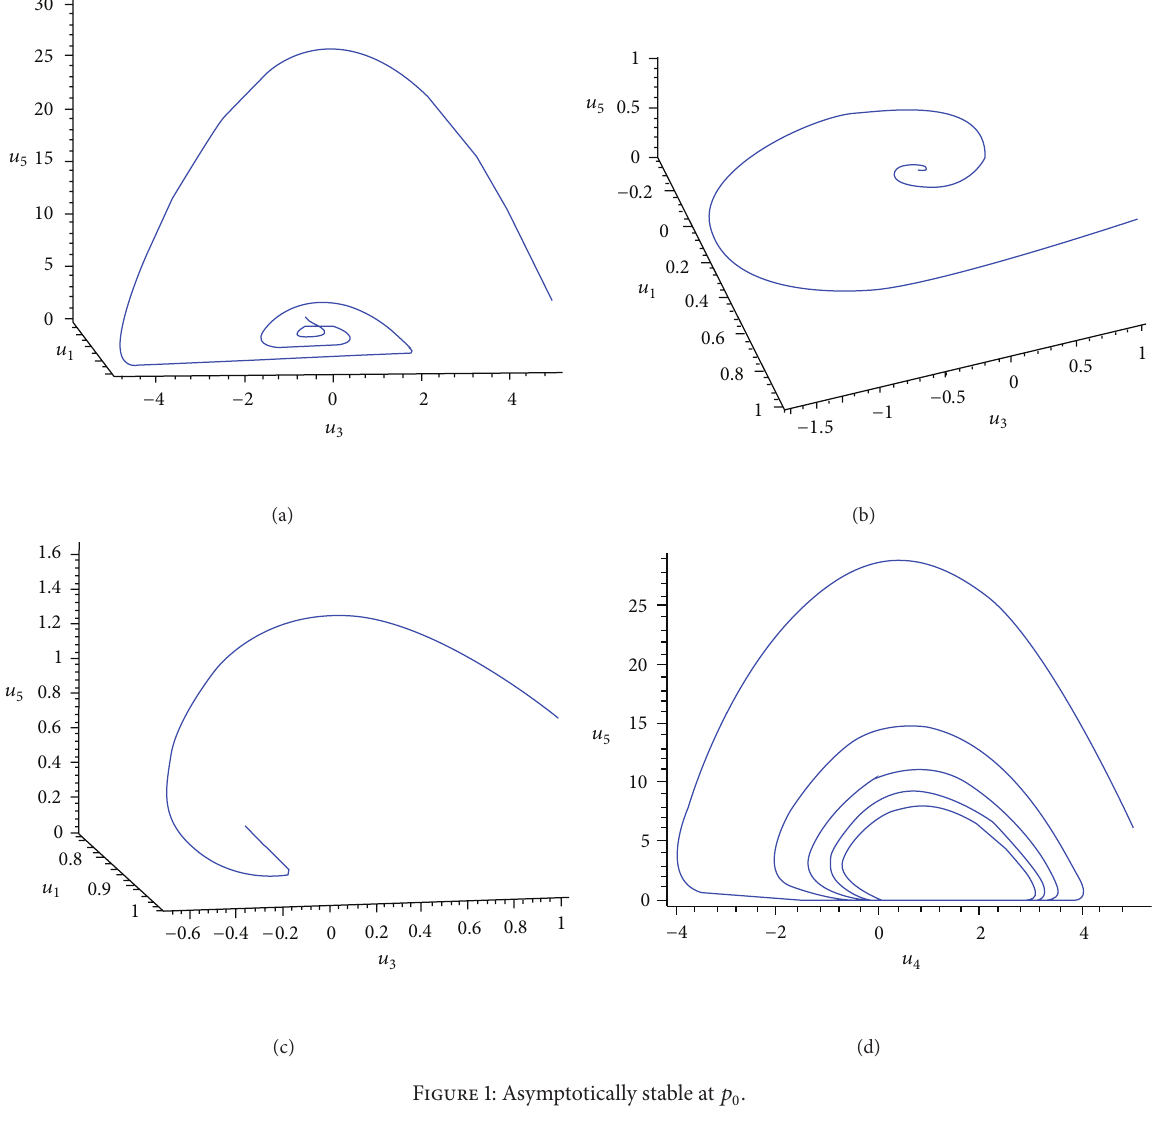
Figure 1: Asymptotically stable at 𝑝 0